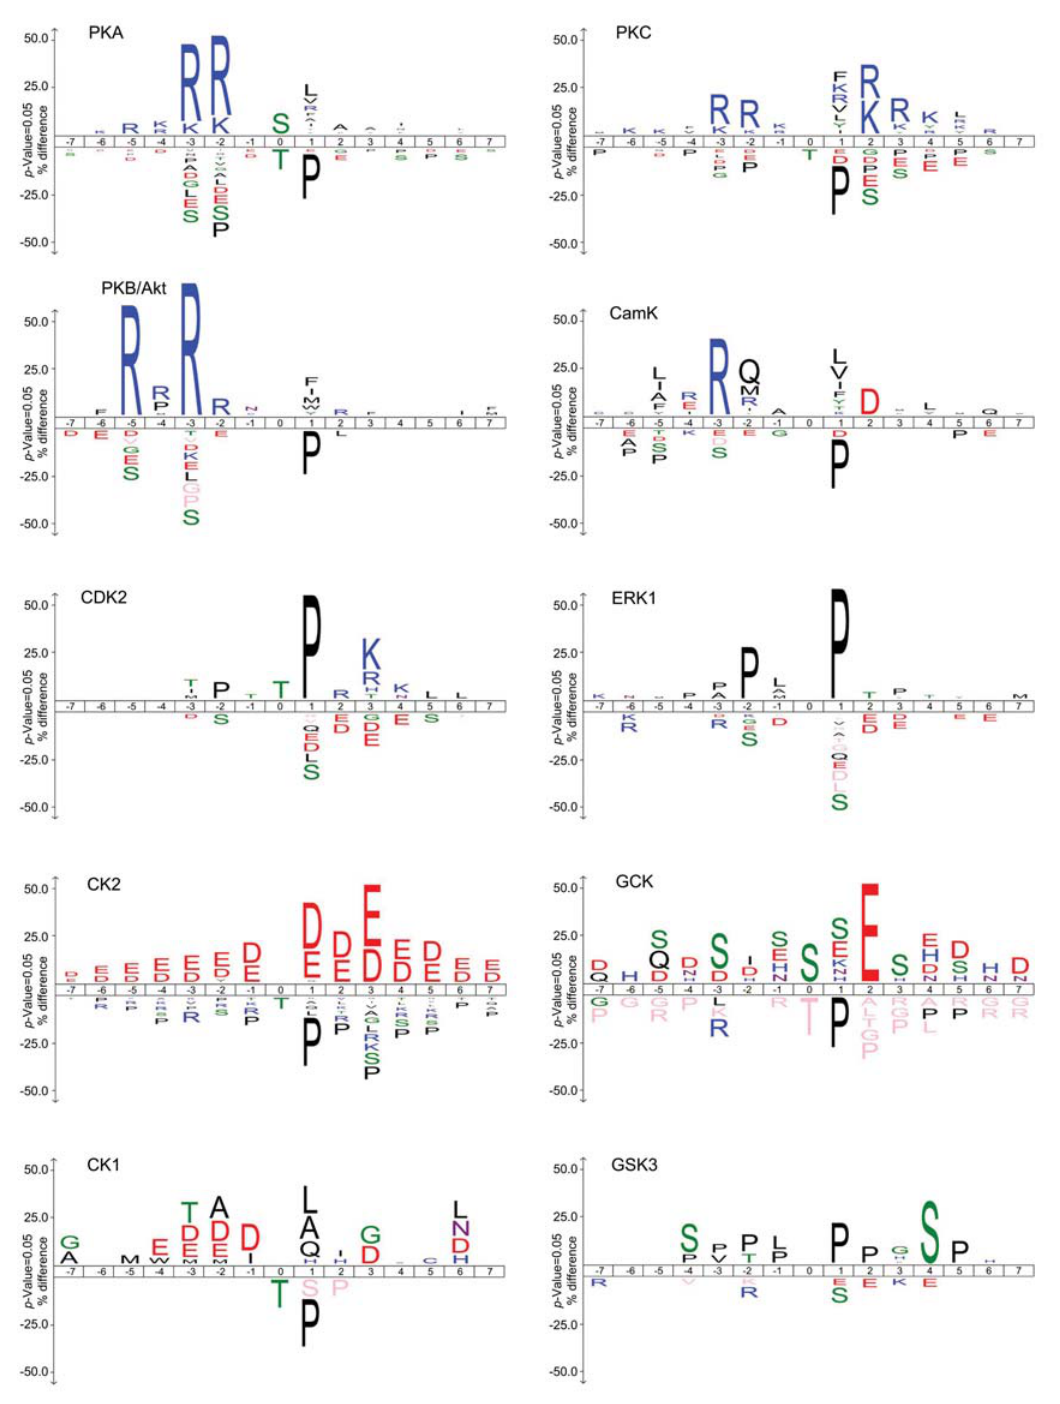
Figure 6 IceLogo analysis of phosphosites generated by individual protein kinases vs. human phospho-S/T proteome. Bona fide substrates for each kinase considered here have been extracted from PhosphoSitePlus (cid:2) and PhosphoElm (15); CK2 substrates have been collected from Ref.